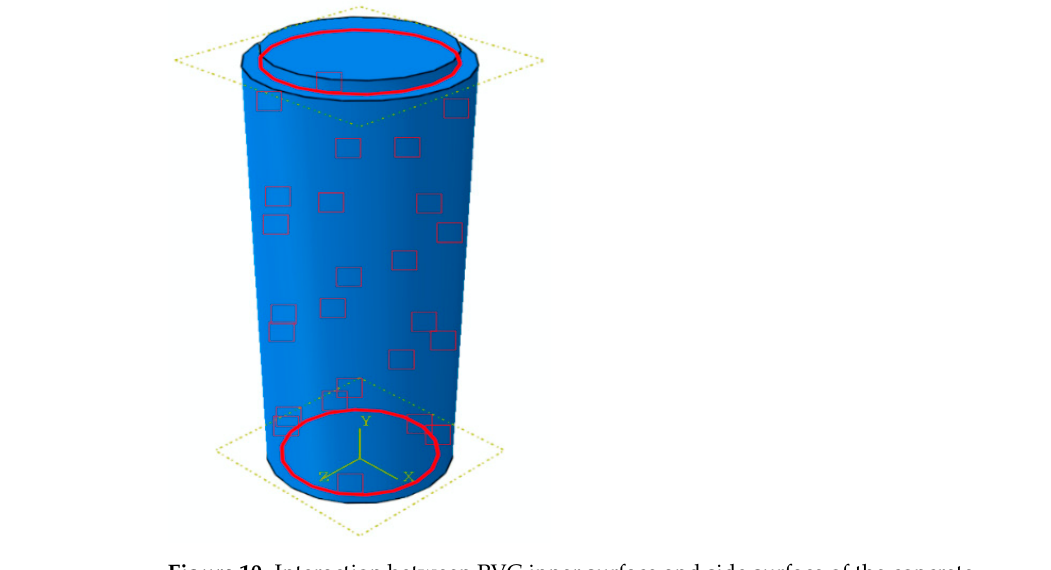
Figure 10. Interaction between PVC inner surface and side surface of the concrete.